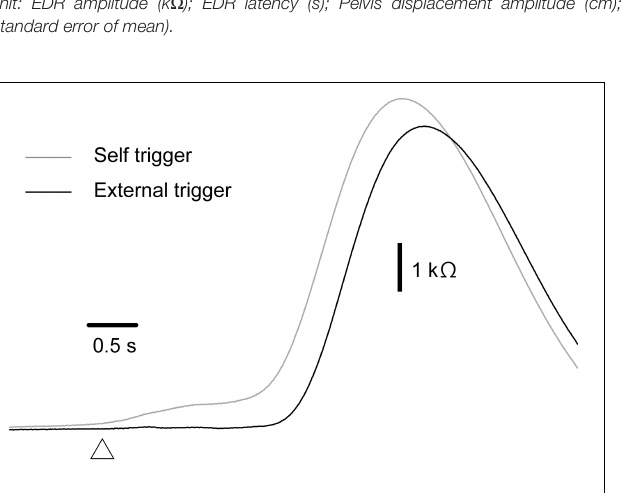
FIGURE 3 | Averaged traces of EDR across 10 trials in the block testing the effect of the time prediction in a